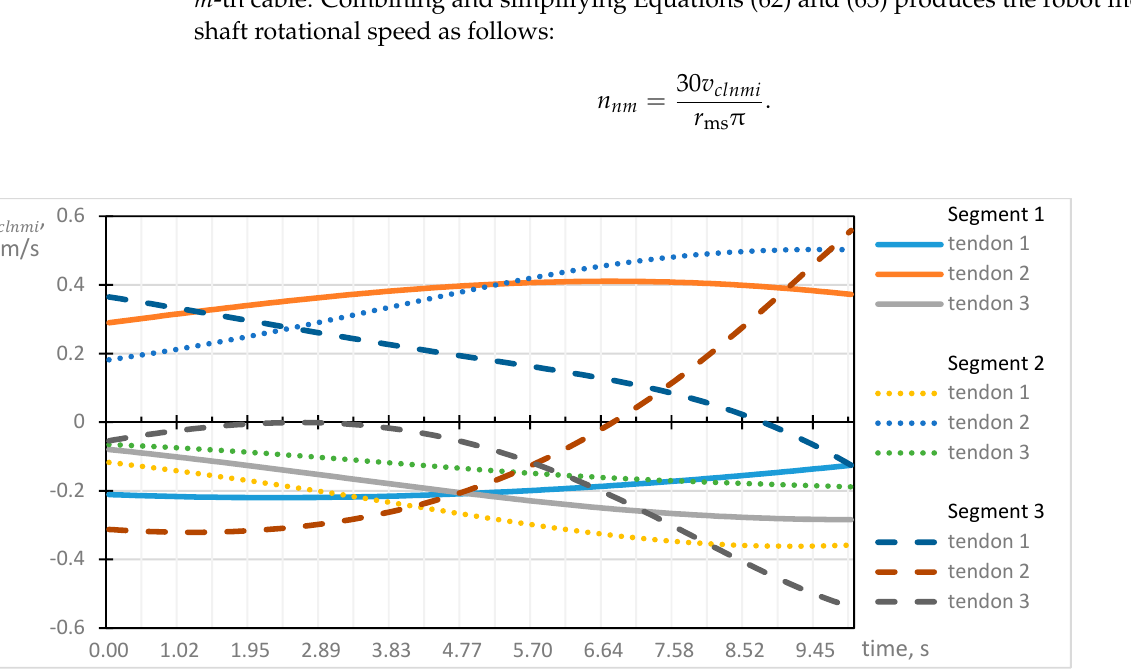
Figure 22. Tendon lengths’ rate of change profiles for robot segments motion (situation represented in Figure 23) from the initial position to the target position.